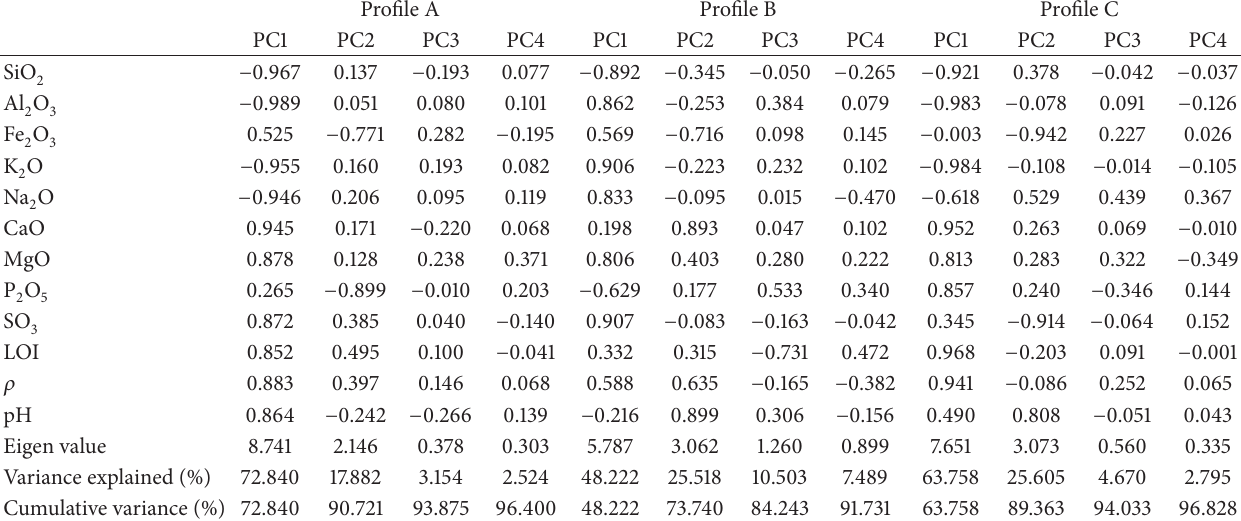
Table 3: Correlations among major elements, density, and pH value with principal components.